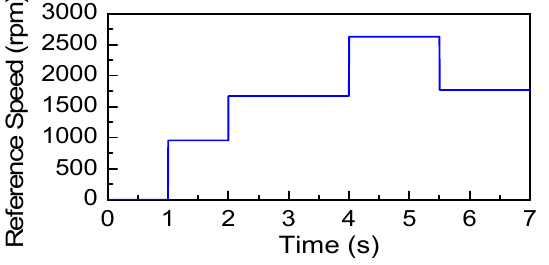
Figure 21. The reference speed variation with the DC-link voltage control strategy when torque is limited at 90 Nm. limited at 90